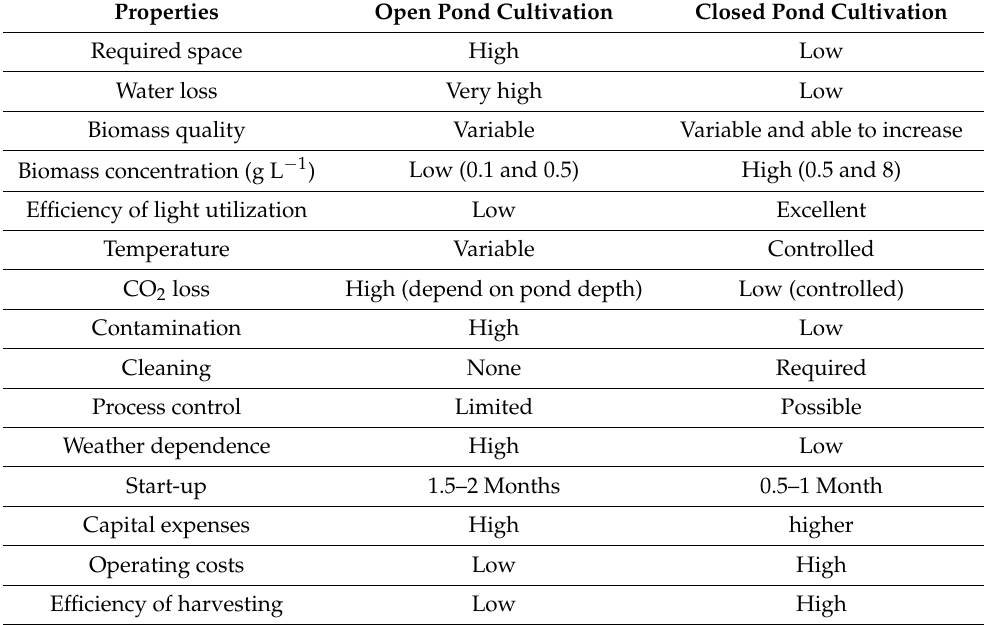
Table 2. Comparison of the two types of microalgae cultivation systems [108].